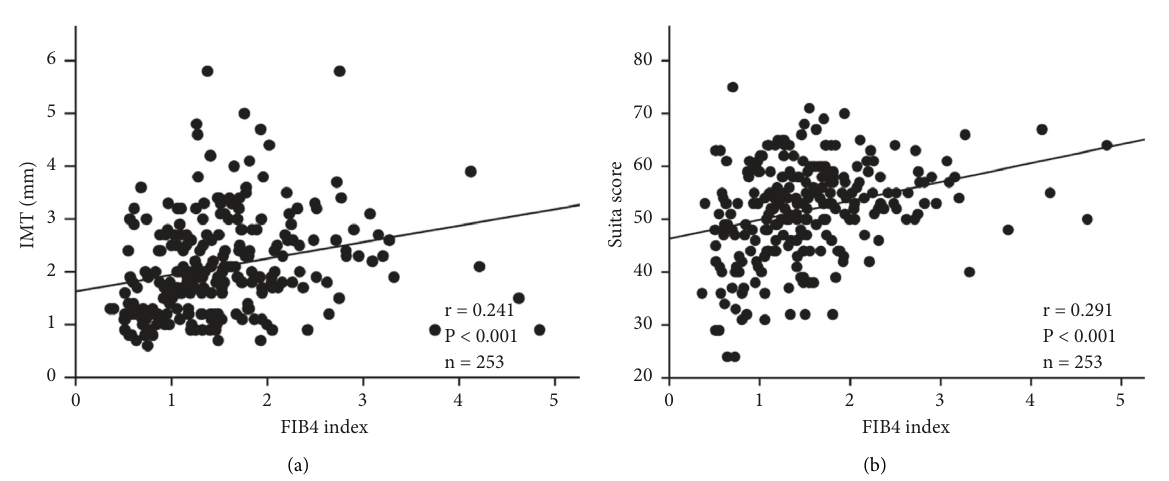
Figure 2: Correlations between FIB4 index and both (a) IMTand (b) suita score. FIB4 index, fibrosis-4 index; IMT, intima-media thickness.